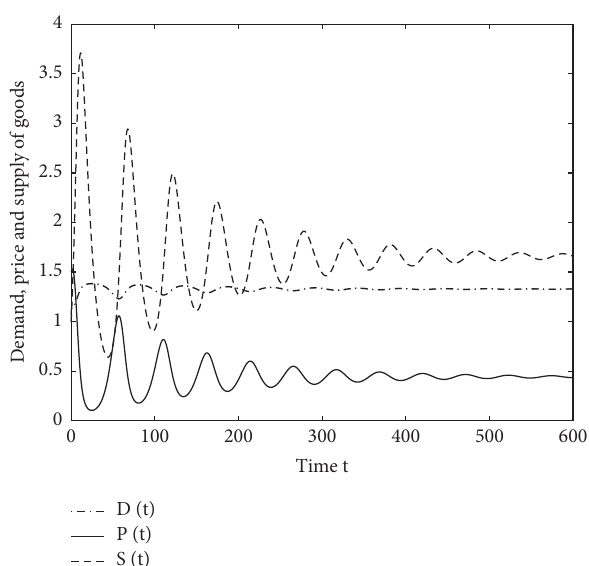
Figure 3: Plane phase diagram of the global asymptotic stability at E